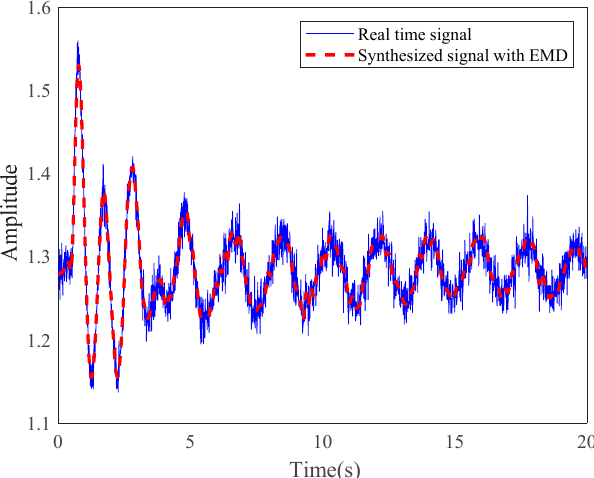
Figure 17. Comparison of the synthesized signal by EMD with the real-time signal. Table 10. Modal parameters of real-time signal identified with SSI approach.